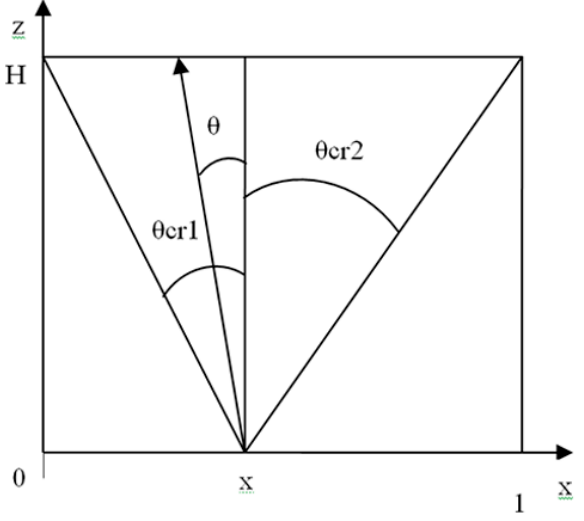
Fig. 1. The scheme of the slot system and the trajectory of de- parture from the system.